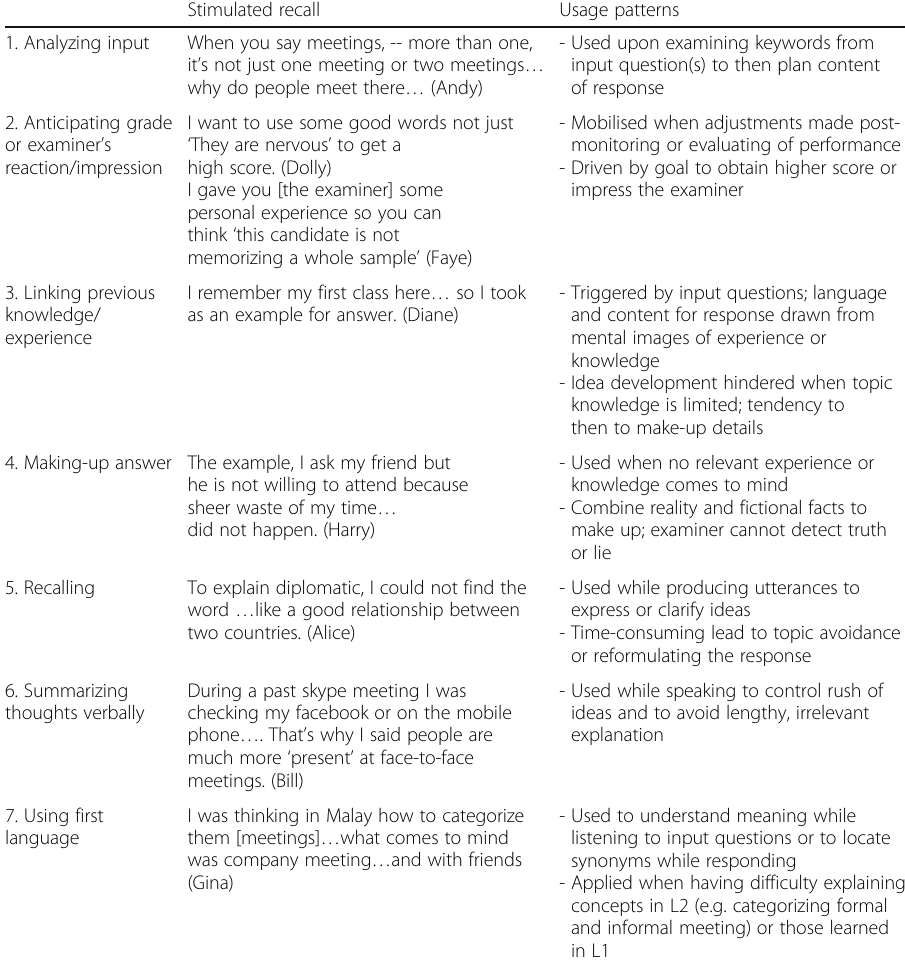
Table 2 Individual cognitive strategies used and usage